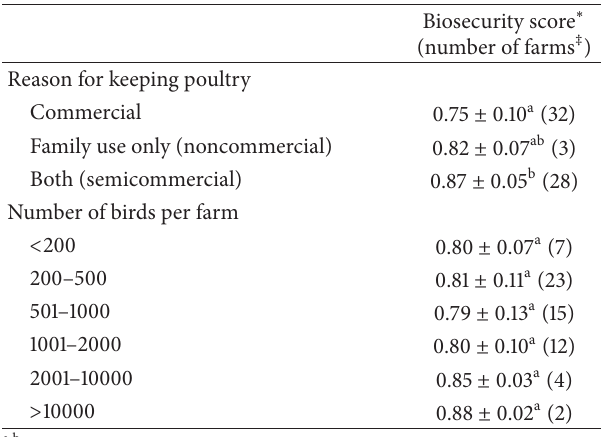
Table 3: Effects of reasons for keeping poultry and number of birds per farm on biosecurity